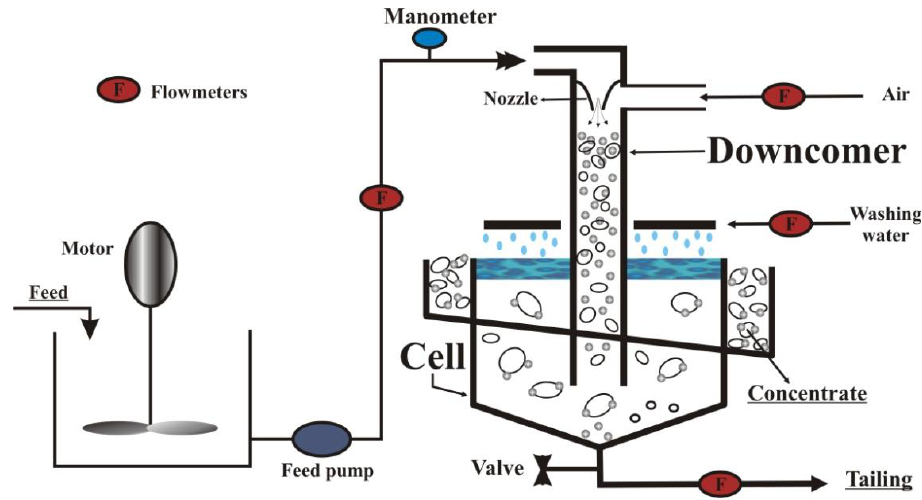
Figure 1. Scheme of a Jameson cell [39].